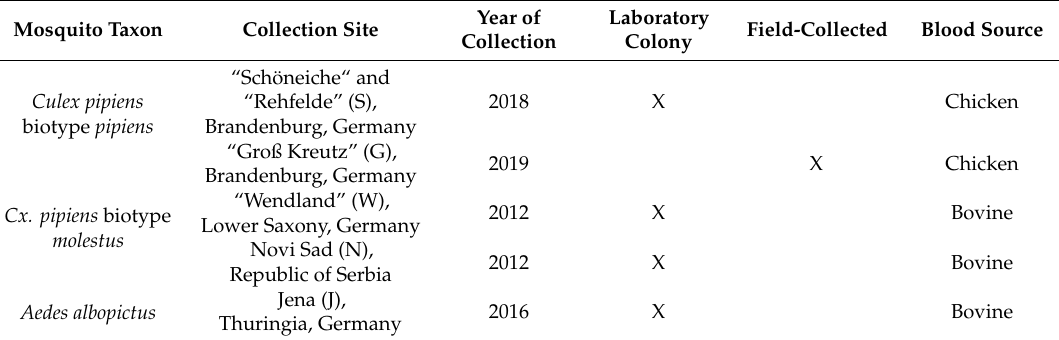
Table 1. Mosquito taxa and blood sources used in the infection experiments.